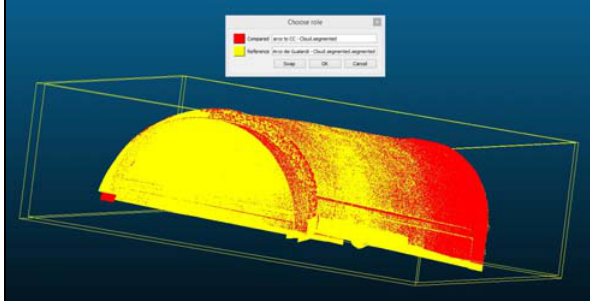
Figure 20 – Overlap of the two point clouds to be compared in “CloudCompare” software: in yellow colour the reference one (Scanned Point Cloud) and in red colour the compared one (Photogrammetric Point Cloud).